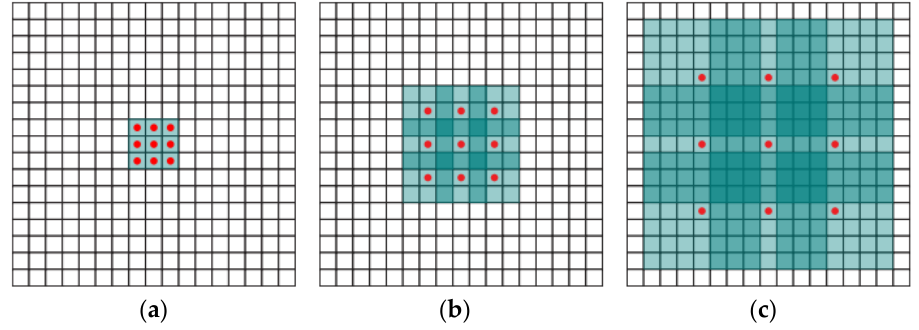
Figure 2. Schematic diagram of receptive field size changes under different expansion parameters. ( a ) The expansion parameter is 1. ( b ) The expansion parameter is 2. ( c ) The expansion parameter is